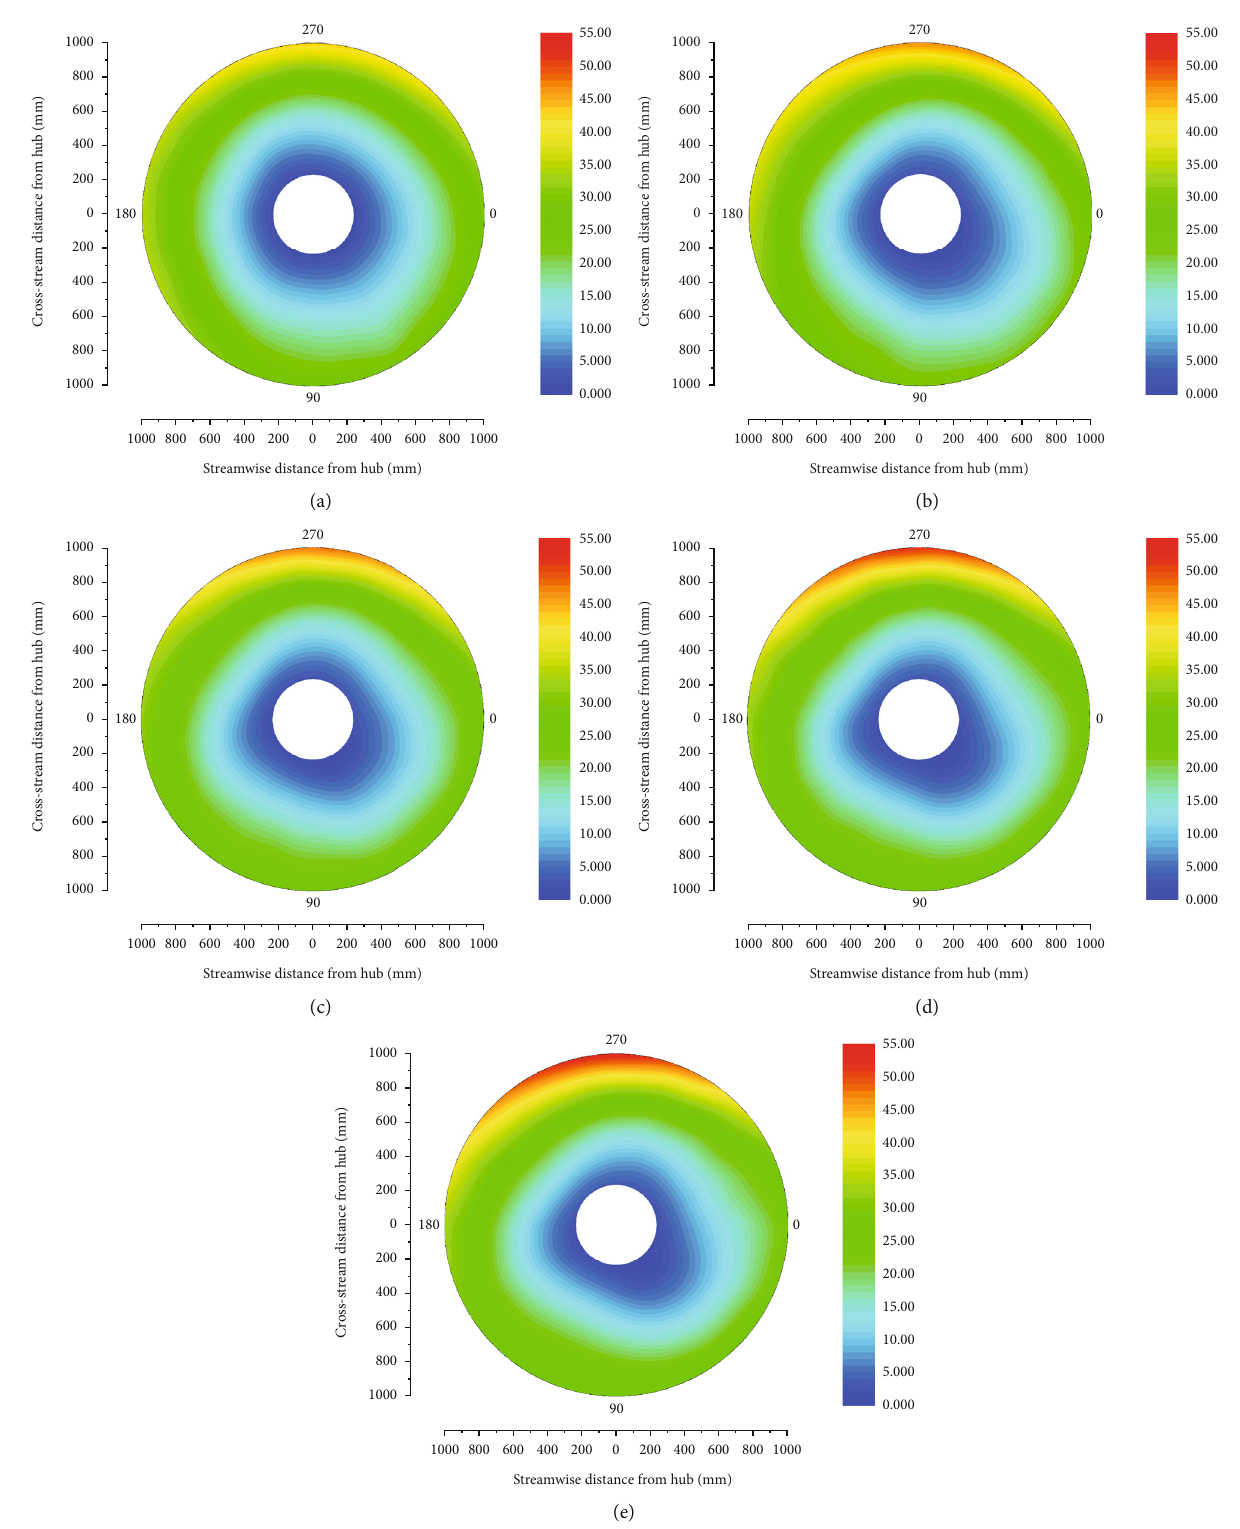
Figure 20: Blade displacements along the quarter-chord at fi ve di ff erent rotor shaft angles in forward fl ight: (a) α = − 4 ° ; (b) α = − 2 ° ; (c) α = 0 ° ; (d) α = 2 ° ; (e) α = 4 °